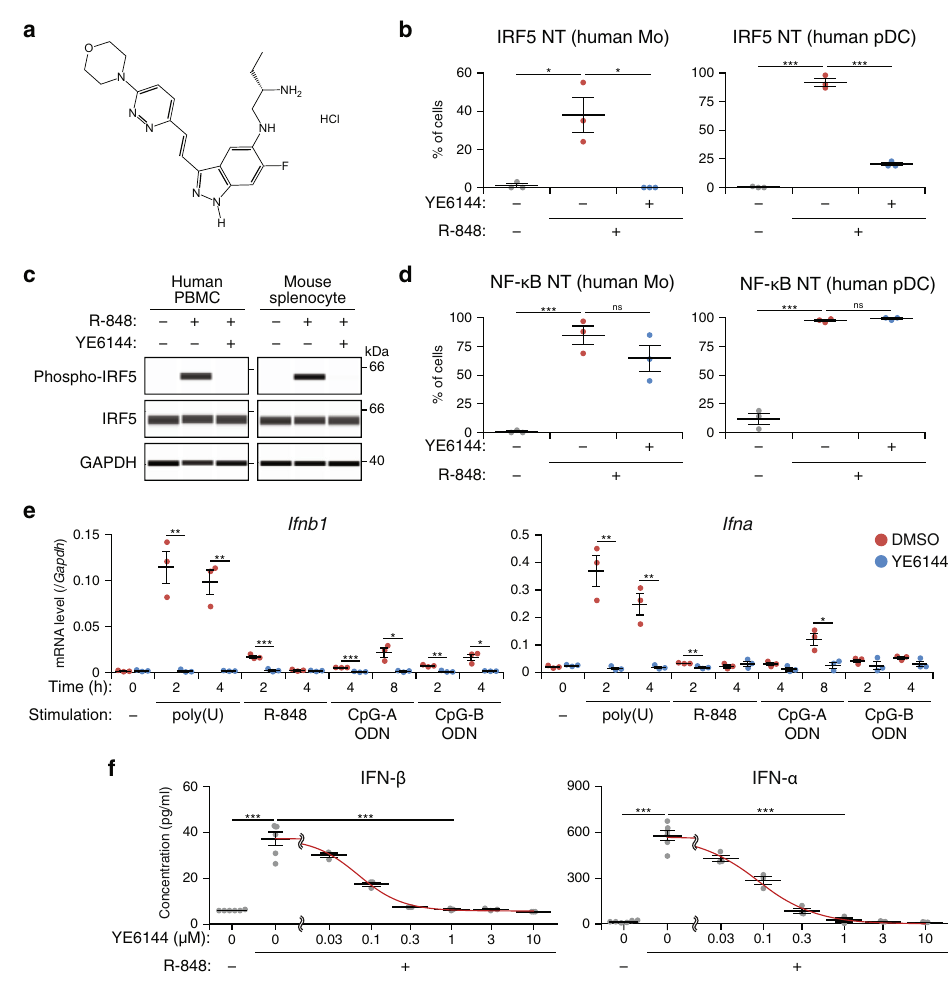
Fig. 5 Suppression of IRF5 and type I IFN by a prototypical IRF5 inhibitor YE6144. a Chemical structure of YE6144. b IRF5 NT in monocytes (Mo; left) or pDCs (right) sorted from human HC PBMCs that were pretreated with the vehicle (DMSO) or 1 μ M YE6144 for 30 min and then were stimulated with 3 μ M R-848 for 30 min. c IRF5 phosphorylation. Human HC PBMCs and mouse WT splenocytes were pretreated with either 1 and 3 μ M YE6144, respectively, or DMSO for 30 min and then stimulated with 3 μ M R-848 for 60 min. Cell lysates were analyzed by the capillary-based immunoassay with antibodies against phospho-IRF5, total IRF5, and GAPDH as a loading control. d NF- κ B p65 NT in cells in b . e , f Type I IFNs. e Mouse WT splenocytes were pretreated with either DMSO or YE6144 for 30 min and next were stimulated with 2 μ g/ml poly(U), 3 μ M R-848, 1 μ M CpG-A ODN, or 0.15 μ M CpG-B ODN for the indicated period. Total RNA was isolated, and the expression of Ifnb1 and Ifna (detection of 12 subtypes) was analyzed by RT-qPCR. f Human HC PBMCs were pretreated with either DMSO (0) or YE6144 at the indicated doses for 30 min and then were stimulated with 3 μ M R-848 for 24 h. IFN- β and IFN- α (detection of four subtypes) in culture supernatants was measured by ELISA. The concentration (0.03 – 10 μ M) of YE6144 was plotted on a logarithmic scale. The red line represents a four-parameter log-logistic dose – response curve. Data in b , d were compiled from three independent experiments ( n = 3 in total). Data in c , e , f are representative of two independent experiments ( n = 3 in e and n = 3 [YE6144] or 6 [DMSO] in f for each experiment). Horizontal bars ( b , d – f ) denote mean ± SEM. * P < 0.05, ** P < 0.01, *** P < 0.001 (two-sided Student ’ s t